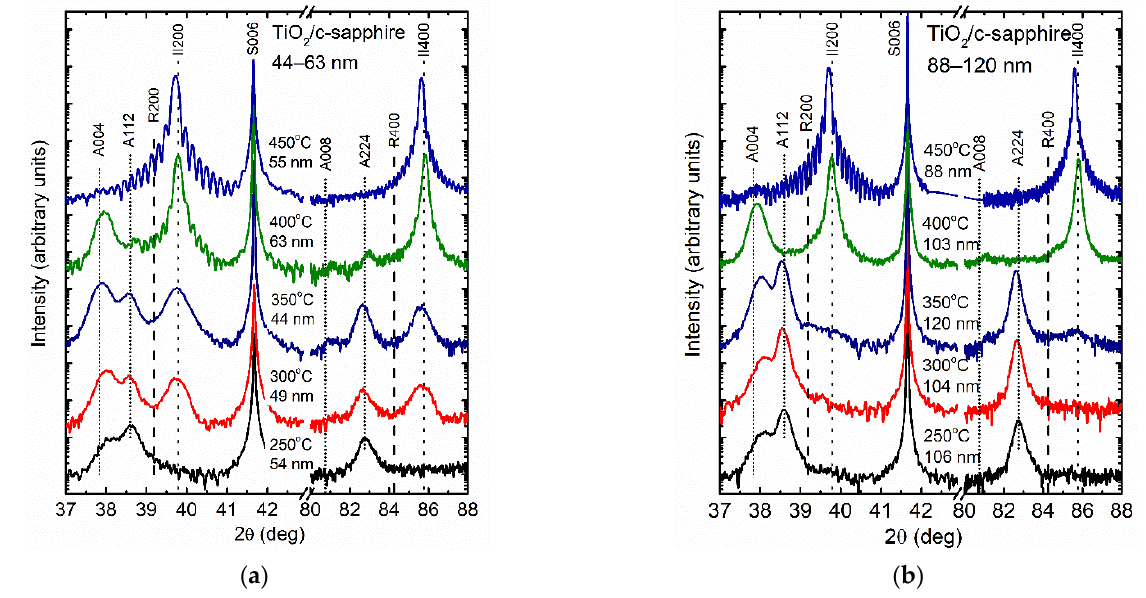
Figure 3. HRXRD patterns of ( a ) 44–63-nm thick and ( b ) 88–113-nm thick TiO 2 films grown on c-sapphire. Growth temperatures, film thicknesses, and Miller indices of anatase (A), rutile (R), TiO 2 -II (II), and sapphire (S) are shown with diffraction patterns. Vertical lines mark the database positions of anatase (PDF 84-1286), rutile (PDF 78-2485), and TiO 2 -II (PDF 01-076-6065) reflections.